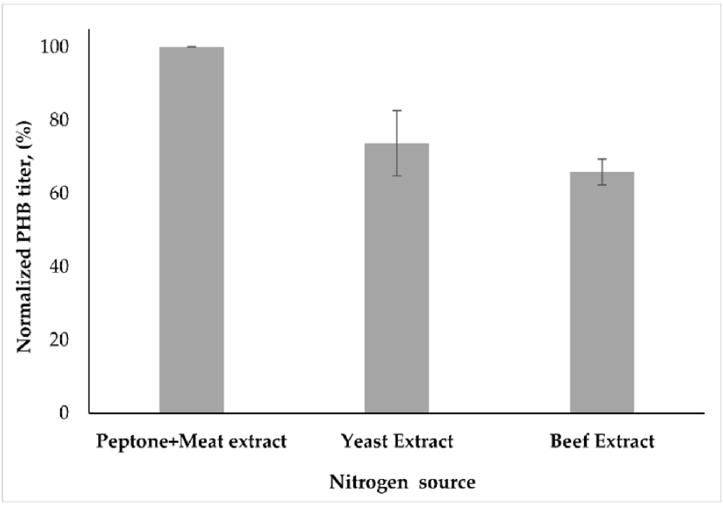
Figure 5. Effect of nitrogen sources on PHB synthesis.